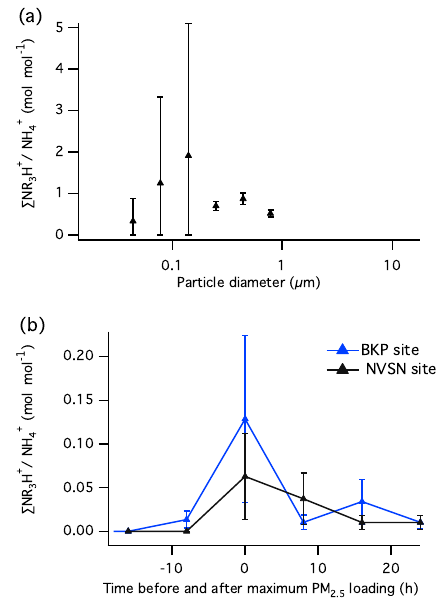
Figure 5. (a) Amine-to-ammonium ratio in the size-resolved aged biomass-burning sample originating from Québec and Labrador in the summer of 2013. (b) Amine-to-ammonium ratio for the Burn- aby/Kensington Park (BKP) site and North Vancouver/Second Nar- rows (NVSN) site in British Columbia during the summer 2015 wildfires. The error bars in the graph represent propagated error in the amine and ammonium quantities resulting from variability in the field blanks and check standards during the analysis of the samples.